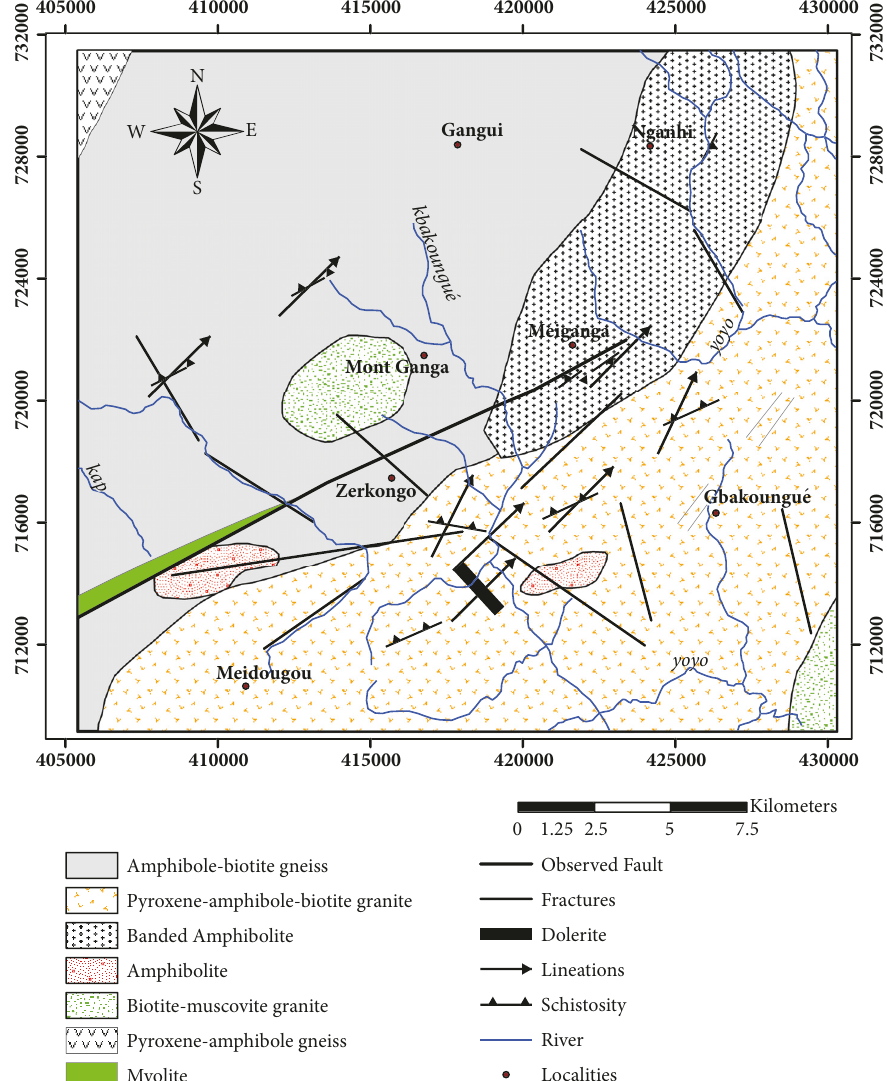
Figure 3: Geology and structural map of M´eiganga area modified from